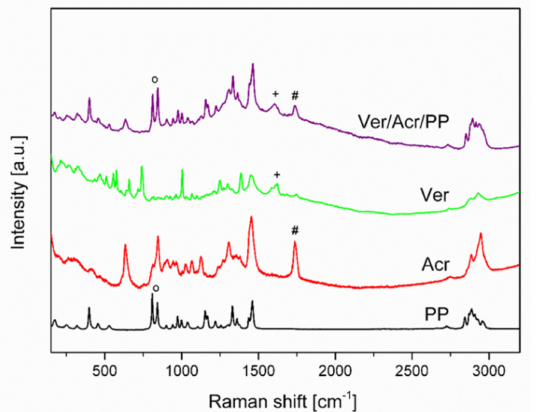
Figure 7. Raman spectra of PP mat modified with Acronal ® 500 D and Vertigo ® 018 EC and spectra of all constituents. O —peak of CH 2 wagging, CCH 3 stretching (809 cm − 1 ) and CC backbone stretching, CH 2 wagging, CCH 3 stretching and CH 3 bending (847 cm − 1 ) of PP, #—peak of the C=O stretching of Acr, +—characteristic band for the Vertigo ® 018 EC. Samples acquisition parameters: power/integration time: PP: 1%/10 s; Acr: 1%/300 s; Ver: 10%/90 s; Ver/Acr/PP: 1%/60 s.